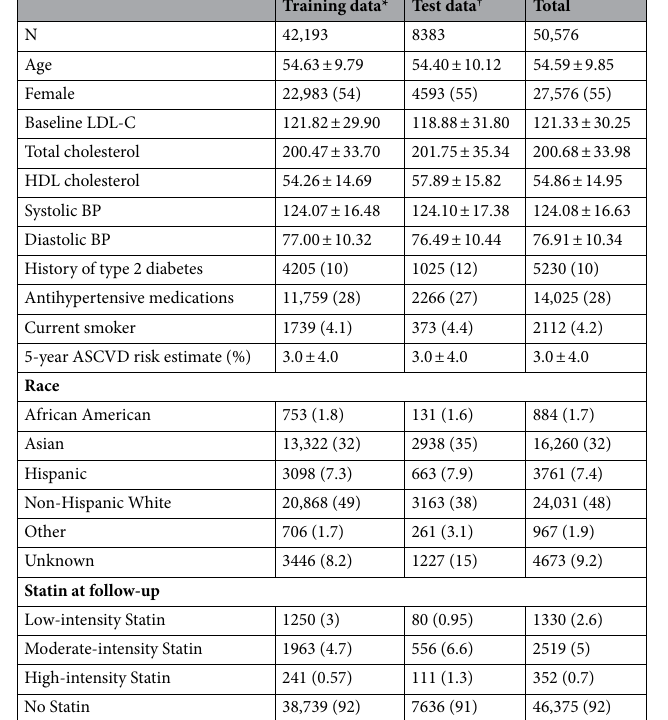
Table 1. Baseline characteristics of the cohort. ASCVD Atherosclerotic cardiovascular disease, BP Blood pressure, HDL High density lipoprotein, LDL-C Low-density lipoprotein cholesterol. *Index date before 2015. † Index date 2015 or